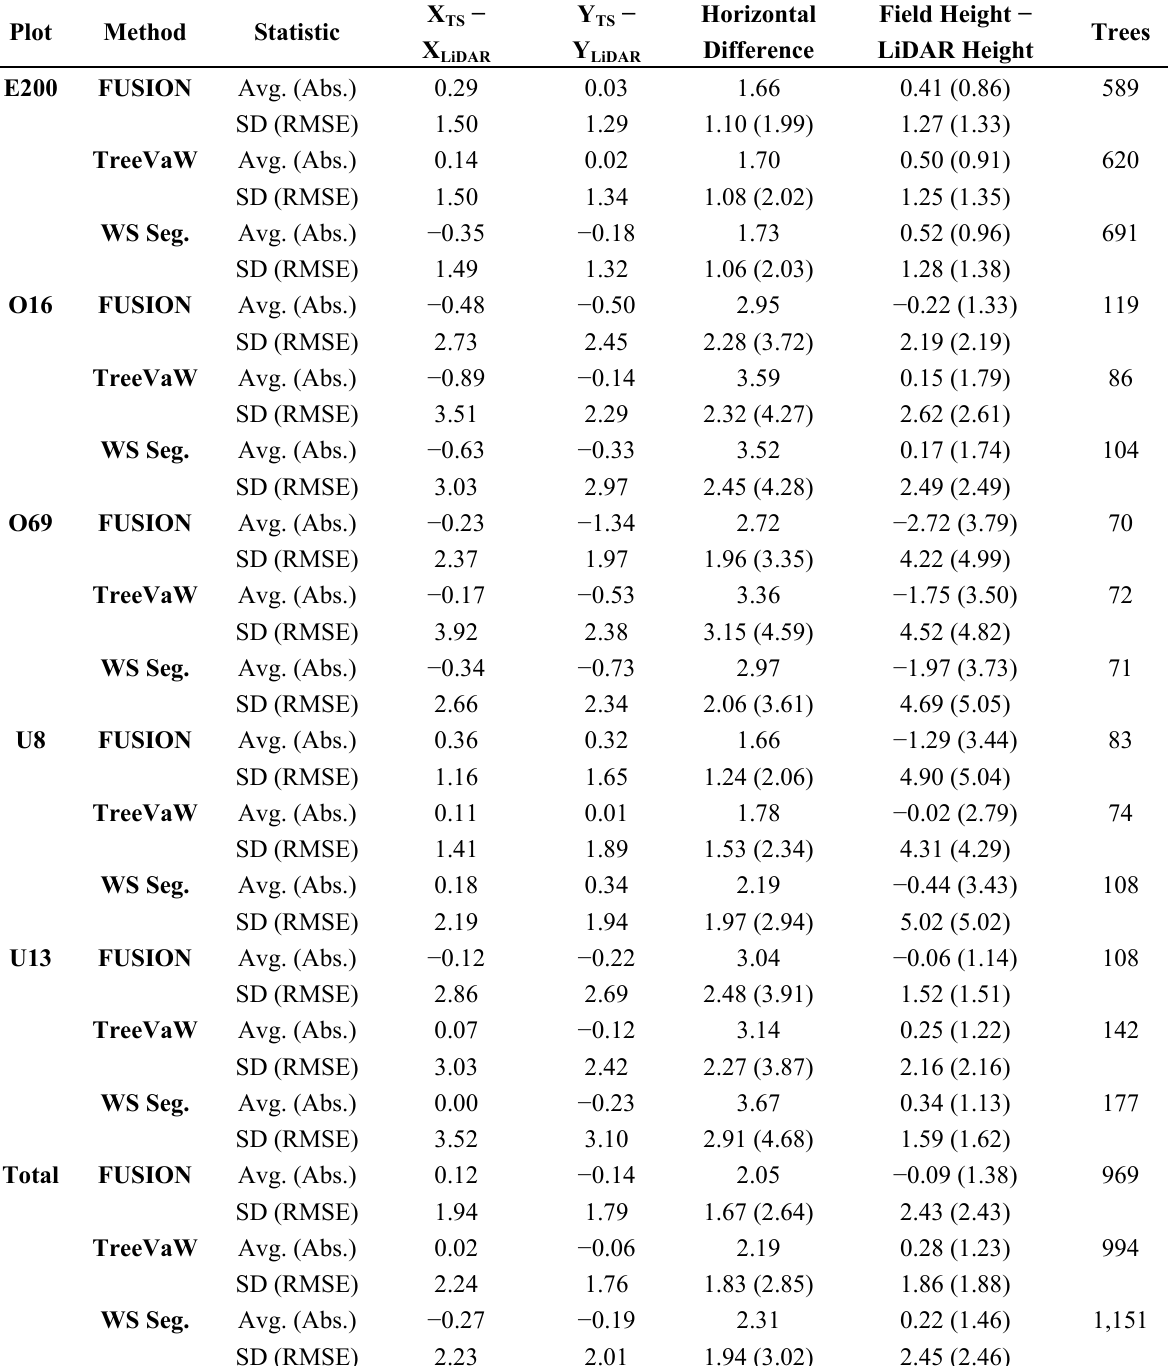
Table 8. LiDAR tree extraction method comparing spatial location and average and absolute tree height* error (m) to field